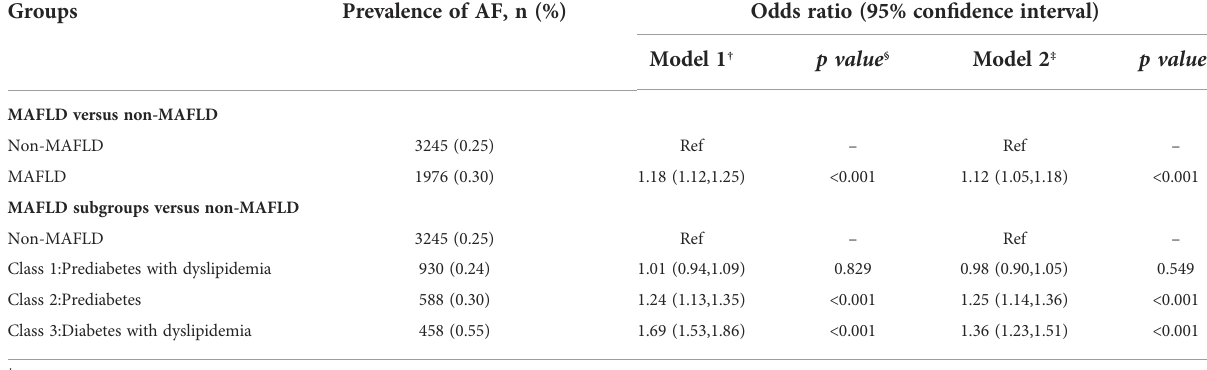
TABLE 2 Association between MAFLD Group/Subclusters and Atrial Fibrillation in the Cross-sectional Analysis. Groups